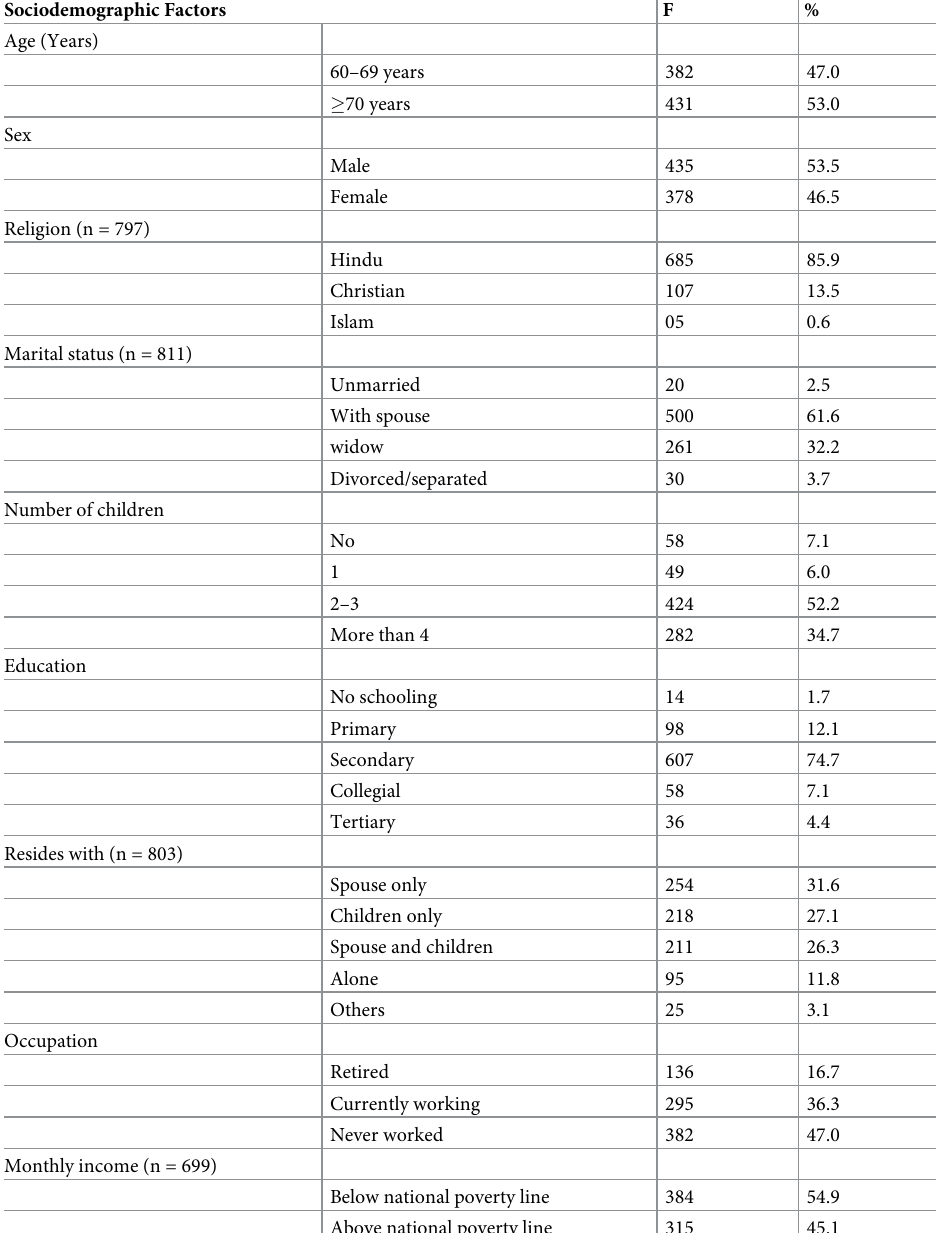
Table 1. Characteristics of the